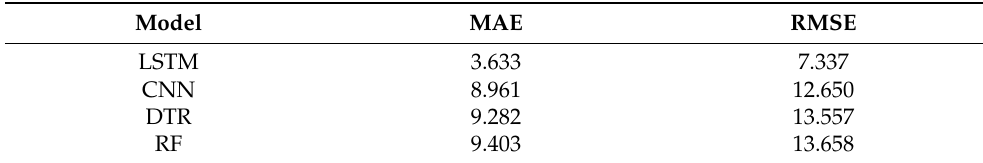
Table 3. MAE and RMSE of four